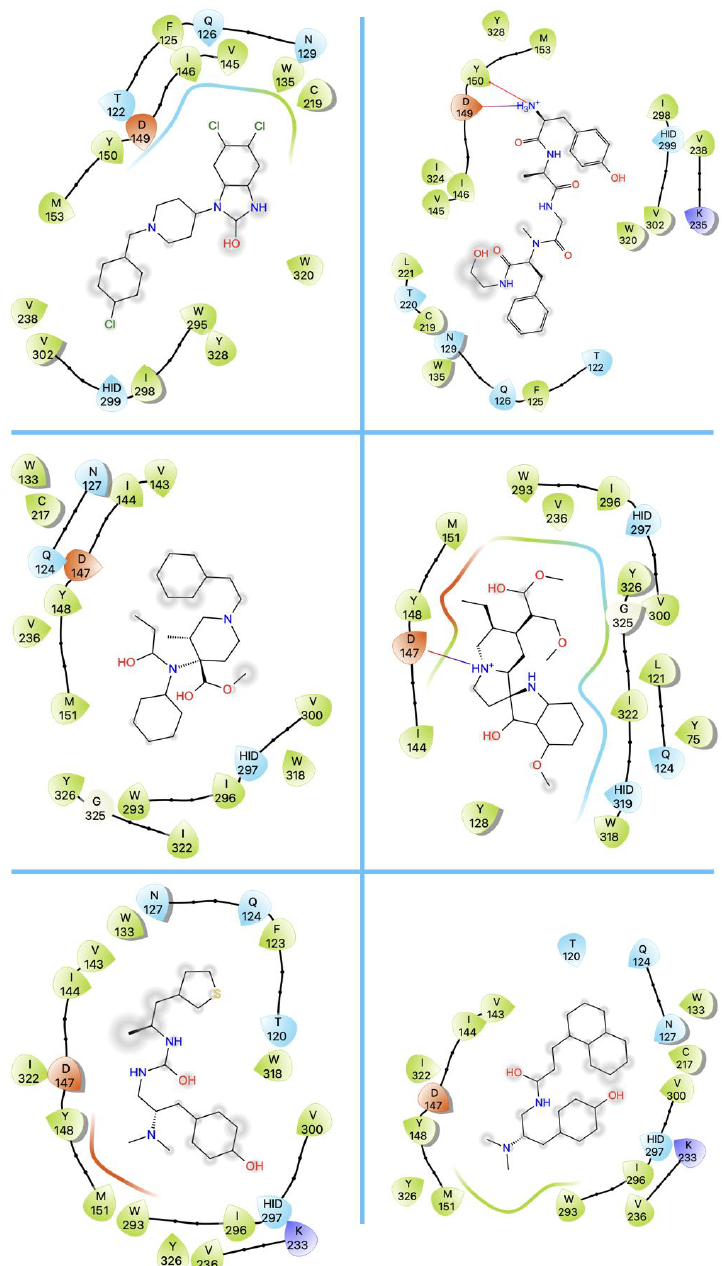
Figure 4. Binding pose comparison of antagonists β-FNA ( top row left ) and alvimopan ( top row right ), agonists BU72 ( row 2 left ), fentanyl ( row 2 right ), morphine ( row 3 left ), DAMGO ( row 4 right ), mitragynine pseudoindoxyl ( row 5 left ), and lofentanil ( row 5 right ), and partial agonists PZM21 ( bottom row left ), FH210 ( bottom row right ), oliceridine (TRV130) ( row 3 right ), and SR17018 ( row 4 left ). This figure was generated using Maestro.